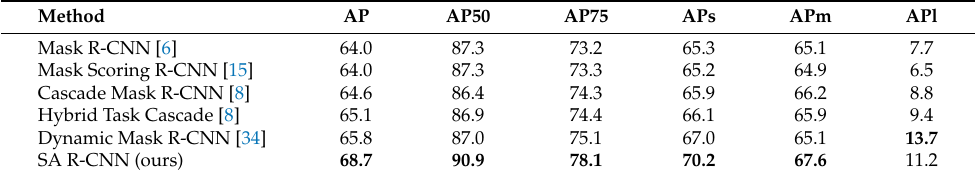
Figure 5. Visible ship instance segmentation results of our SA R-CNN compared with some state-of-the-art methods on complex scenes from the test set of HRSID. The green bounding box denotes the ground truth and the orange bounding box denotes the predicted results. The numbers of failed detections and false alarms are shown below. Table 1. Detection performance comparison between different instance segmentation methods on